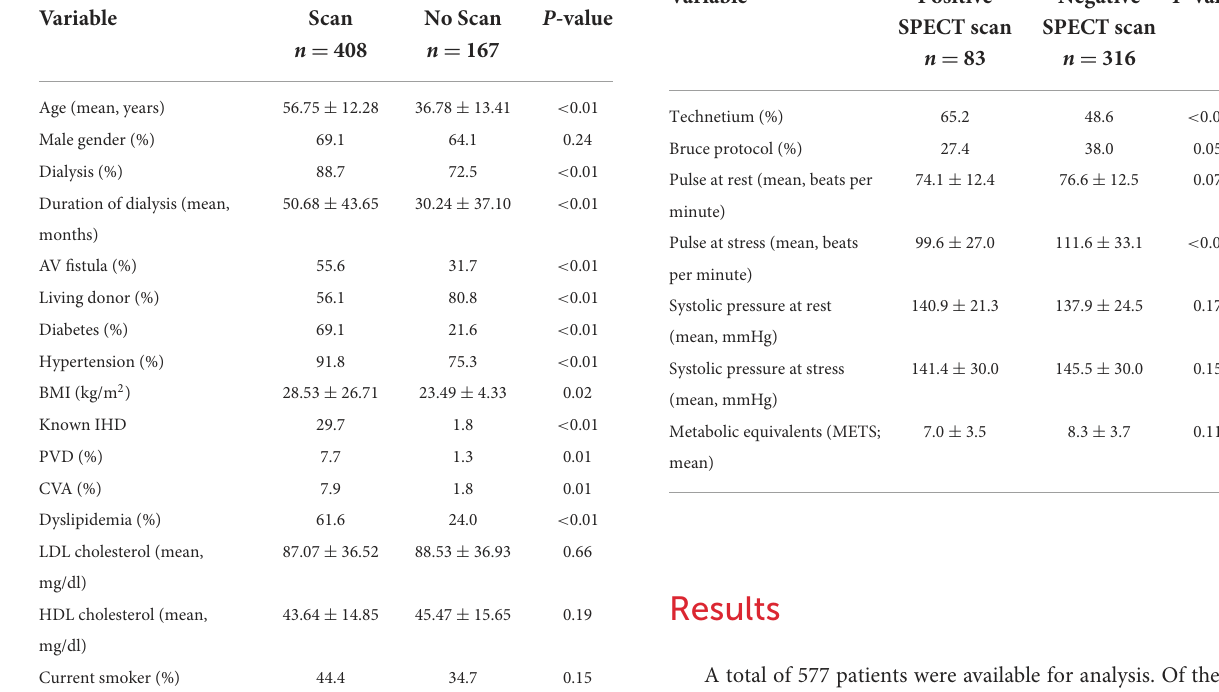
TABLE 2 SPECT scan characteristics of patient groups according to SPECT scan